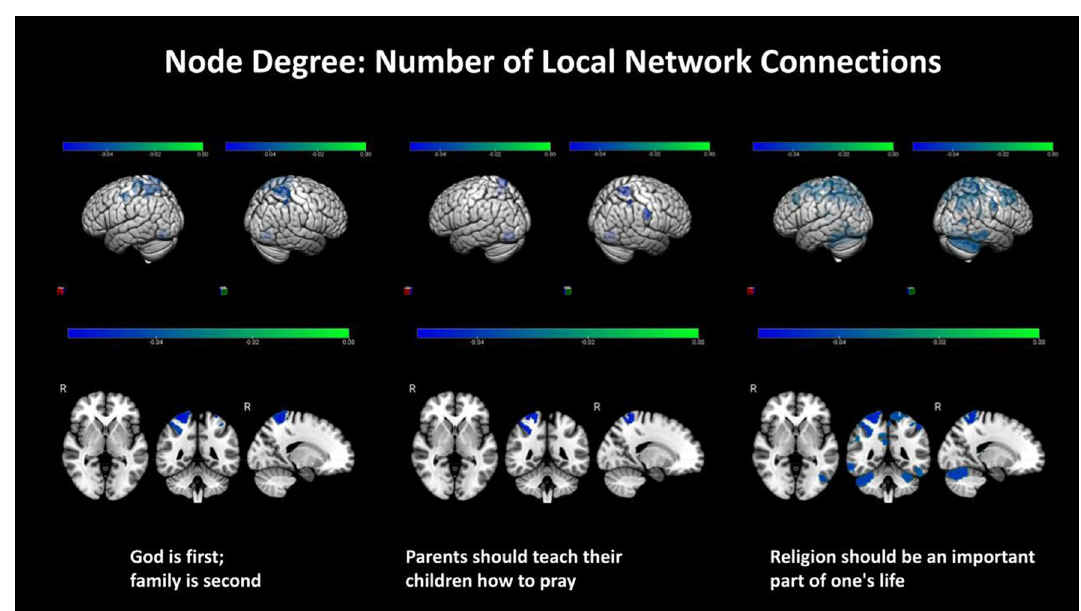
Figure 3. Significant negative associations were estimated, between strength of religious beliefs, including God is first, family is second, parents should teach their children how to pray, and religion should be an important part of one’s life and regional connectedness (degree). The colorbars represent the range of negative (green–blue) standardized regression coefficient values in statistical models that assessed these effects. Two and three- dimensional views of both hemispheres are